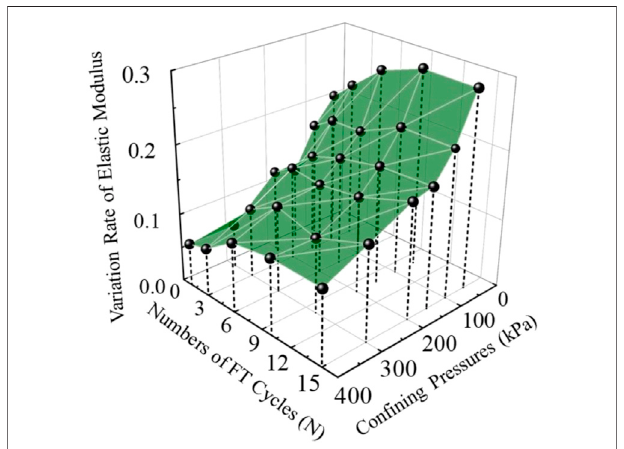
FIGURE 13 | Results of V with various N as well as σ 3